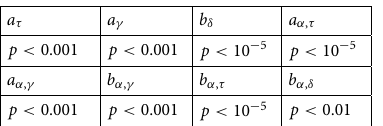
Table 4. Significant MsCr measures in Schizophrenia—full data set.